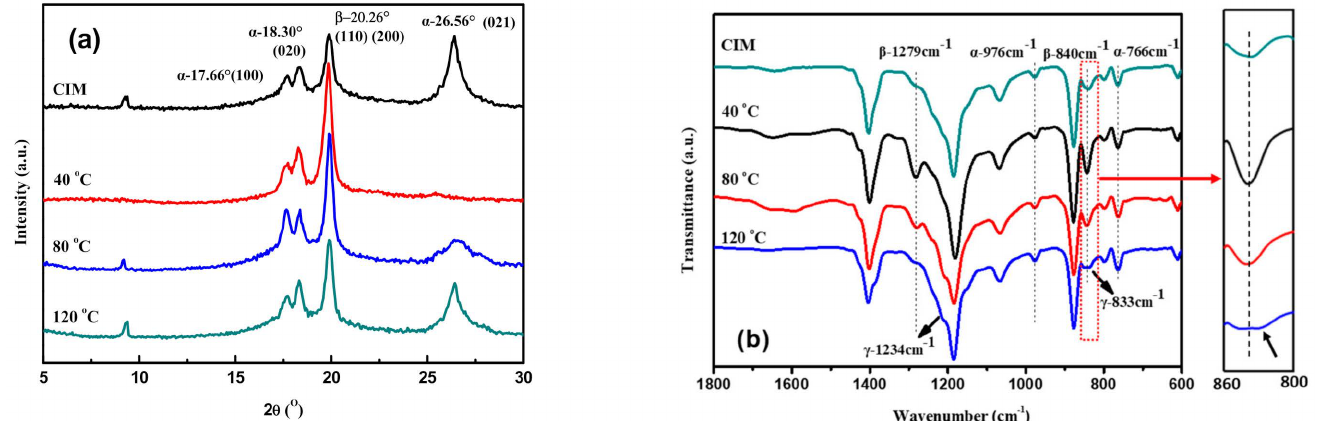
Figure 12. XRD spectra ( a ) and FTIR spectra ( b ) of PVDF/GP micro-parts at different cavity temperature (Injection speed: 300 mm/s; GP content: 1 wt%).